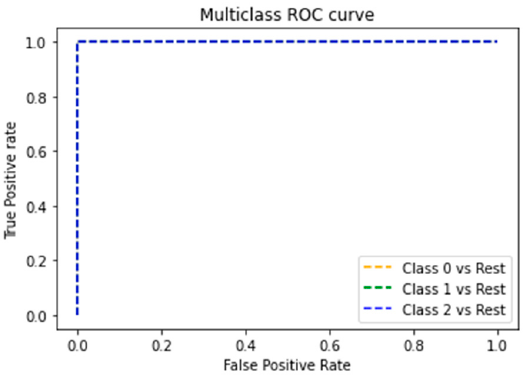
Figure 12. ROC curve graph of the classes that represent the freshness of salmon meat.